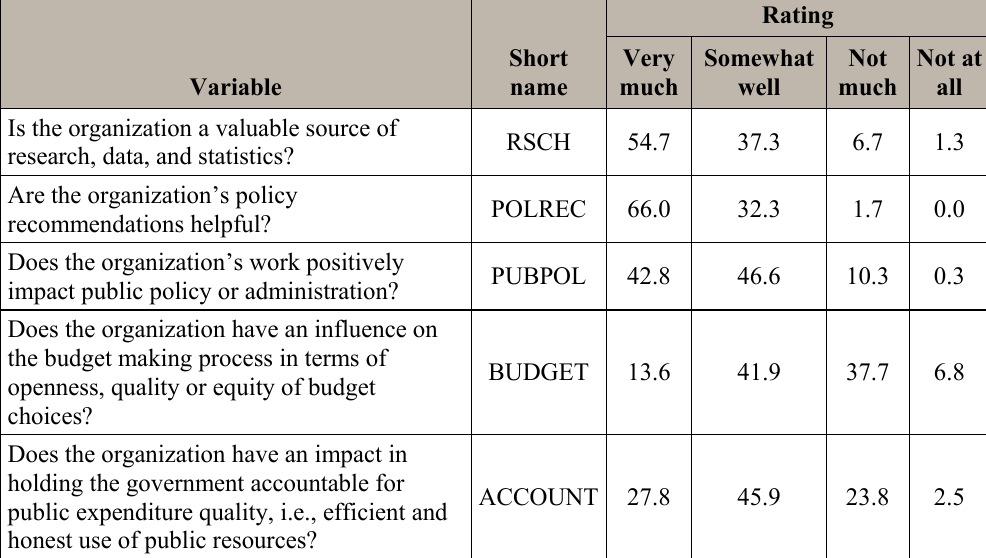
Questions Used in Constructing Dependent Variables for Policy Effectiveness